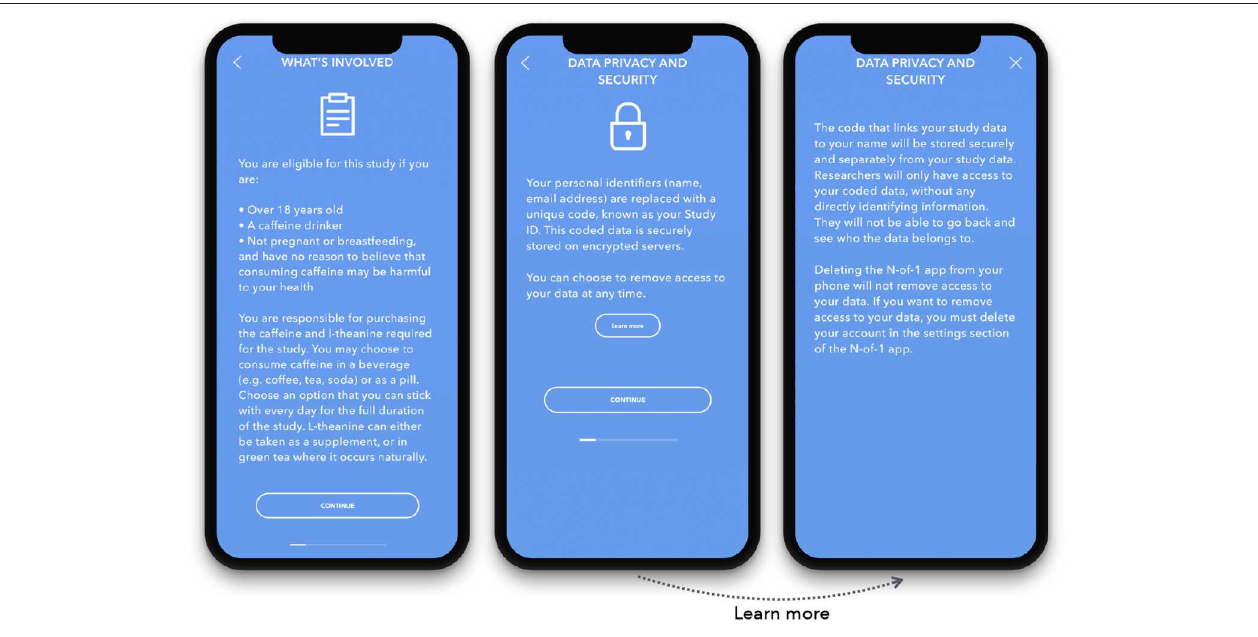
FIGURE 4 | Sample screens from the digital consent module.